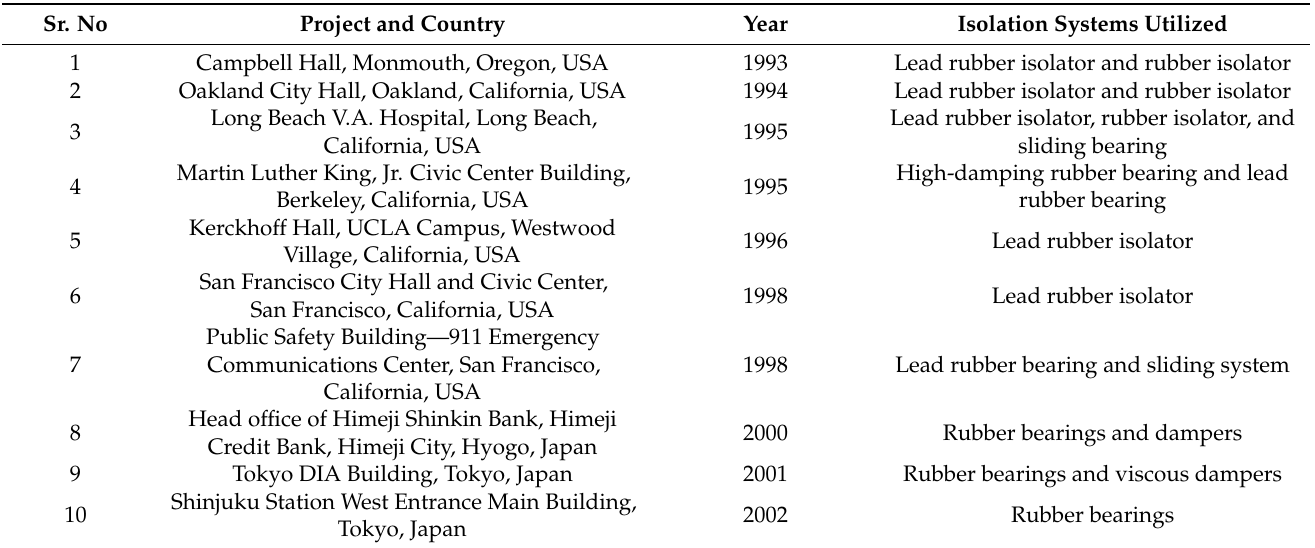
Table 4. Major building retrofit projects using base isolation (Matsagar et al., 2008). Sr.